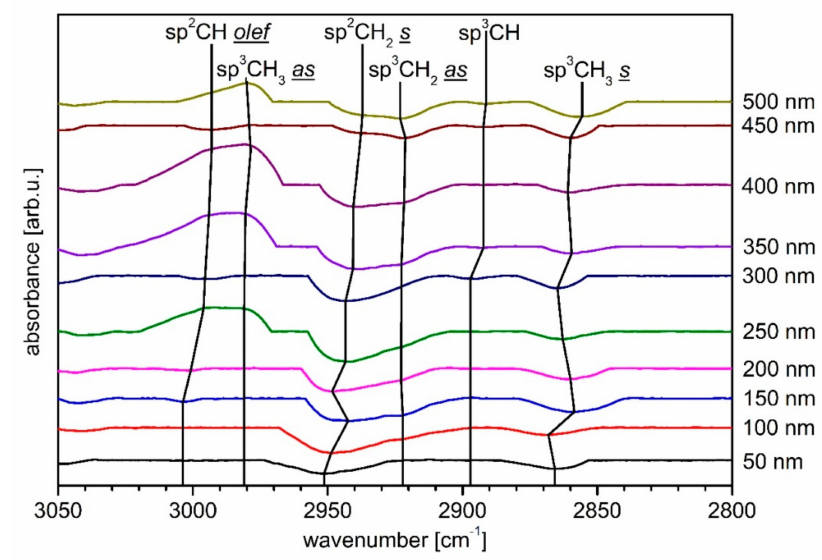
Figure 6. Di ff use reflectance infrared Fourier transform spectroscopy (DRIFT) spectra of the analyzed a-C:H layers with increasing thickness on PBAT. The rising layer thickness is indicated by changing colors with number labelling right next to